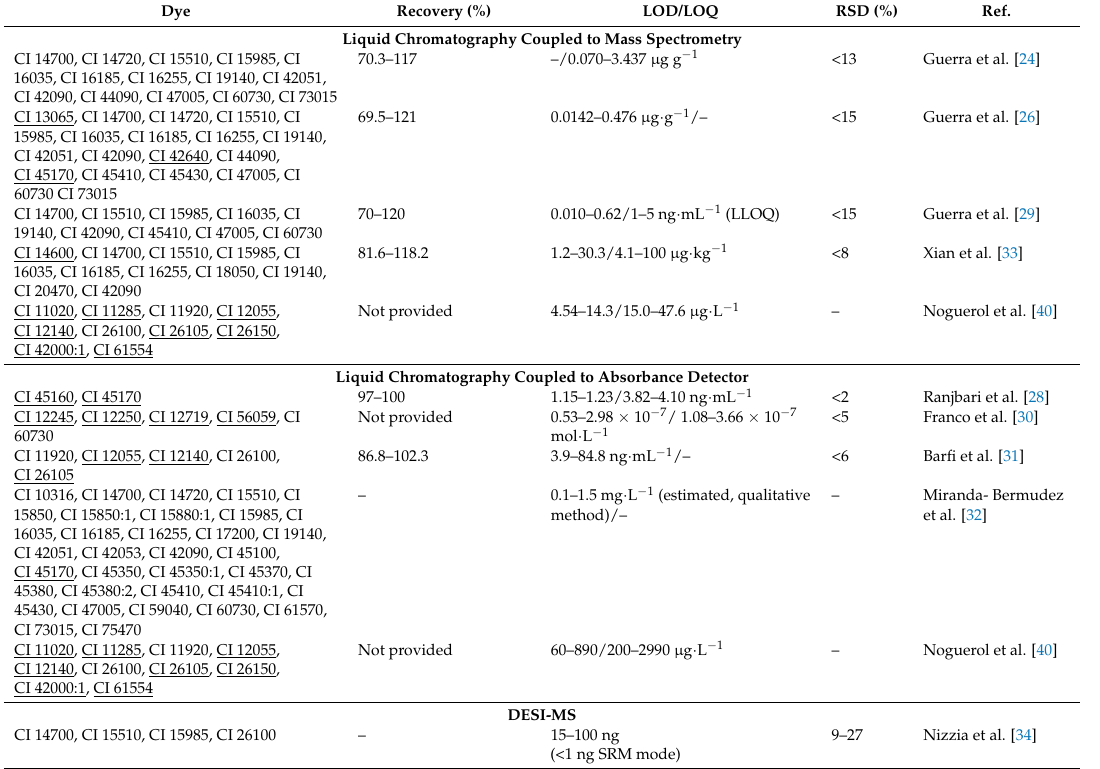
Table 3. Performance of analytical methodologies for multi-dye determination in cosmetics (2008–2018). Dye Recovery